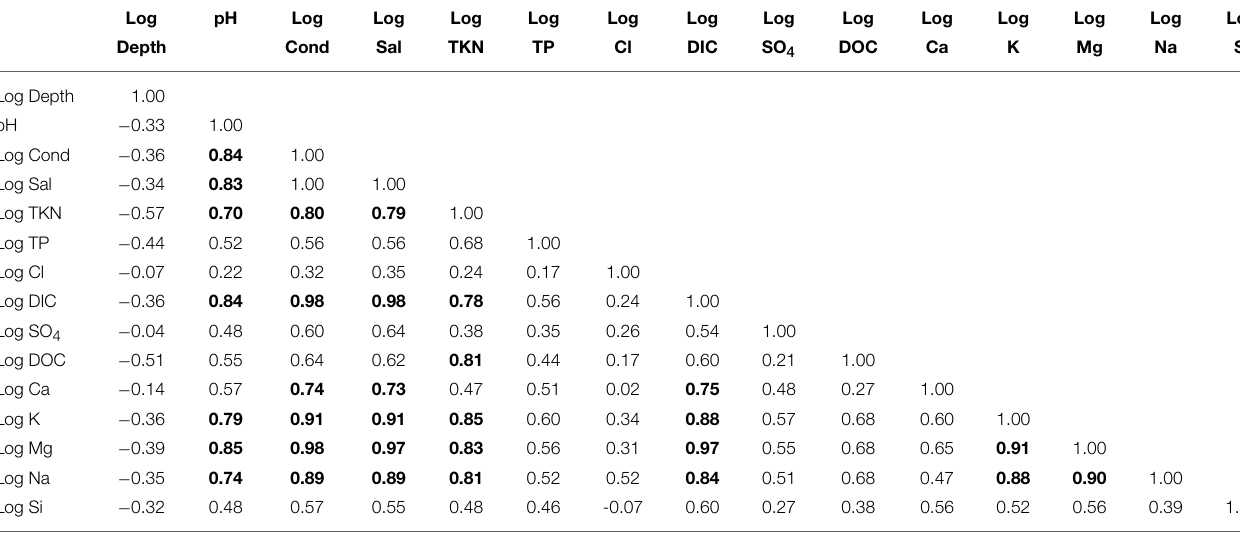
TABLE 1 | Correlation matrix of the environmental variables in 244 calibration lakes for which complete chemistry was available. Log pH Log Log Log Log Log Log Log Log Log Log Log Log Log Depth Cond Sal